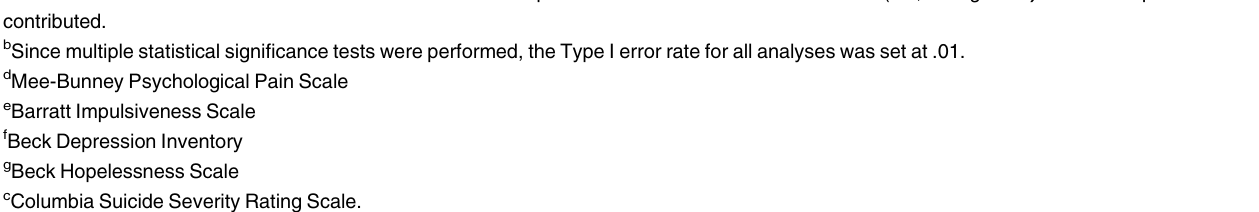
had dropped out of the VA program and had an above threshold score (MBP = 33). Two other SSE patients had high but slightly below-threshold scores of 30 and 31, respectively. There were no other suicide events. Logistic regression did not identify any baseline variables that predicted future SSEs. This is likely a consequence of the small number of subjects having a serious suicide event combined with a relatively low variability in scale scores. Examination of MBP scores categorically (MBP < 32; MBP (cid:21) 32) did however suggest a relationship with future SSEs (Chi-squared = 5.58, df = 1, p = .018) but did not reach significance since we are using a Type 1 error rate of 0.1.